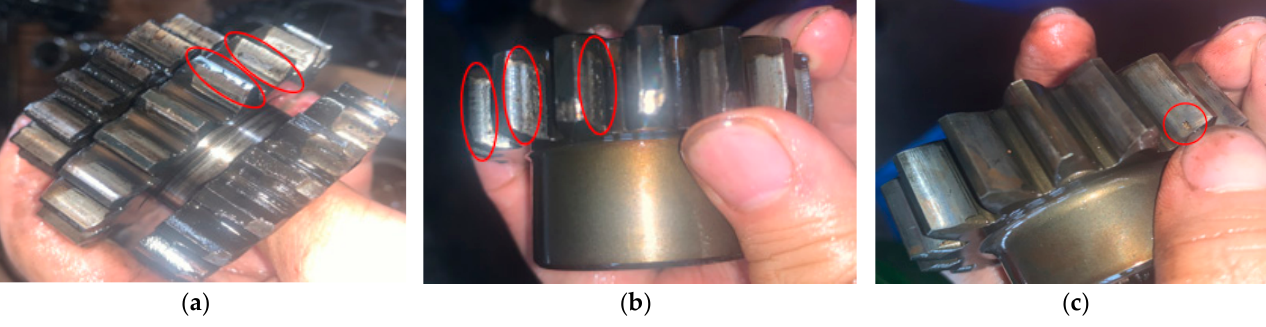
Figure 11. Damage of third-gear drive gear ( a ), third-gear driven gear ( b ) and power shunt gear ( c ) inside the gearbox.